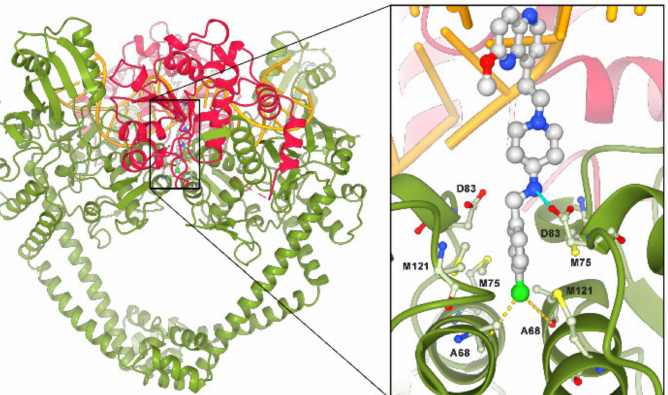
Figure 1. Binding mode representation of an NBTI ligand (inset, grey, compound 13 ) in a complex with S. aureus DNA gyrase and DNA molecule (PDB ID: 6Z1A) [13]. The GyrA subunit is shown in green, the gyrase B (GyrB) subunit is red, while the DNA molecule is orange. Ionic interaction is shown as cyan dots, while the bifurcated symmetrical halogen bonds are represented as yellow